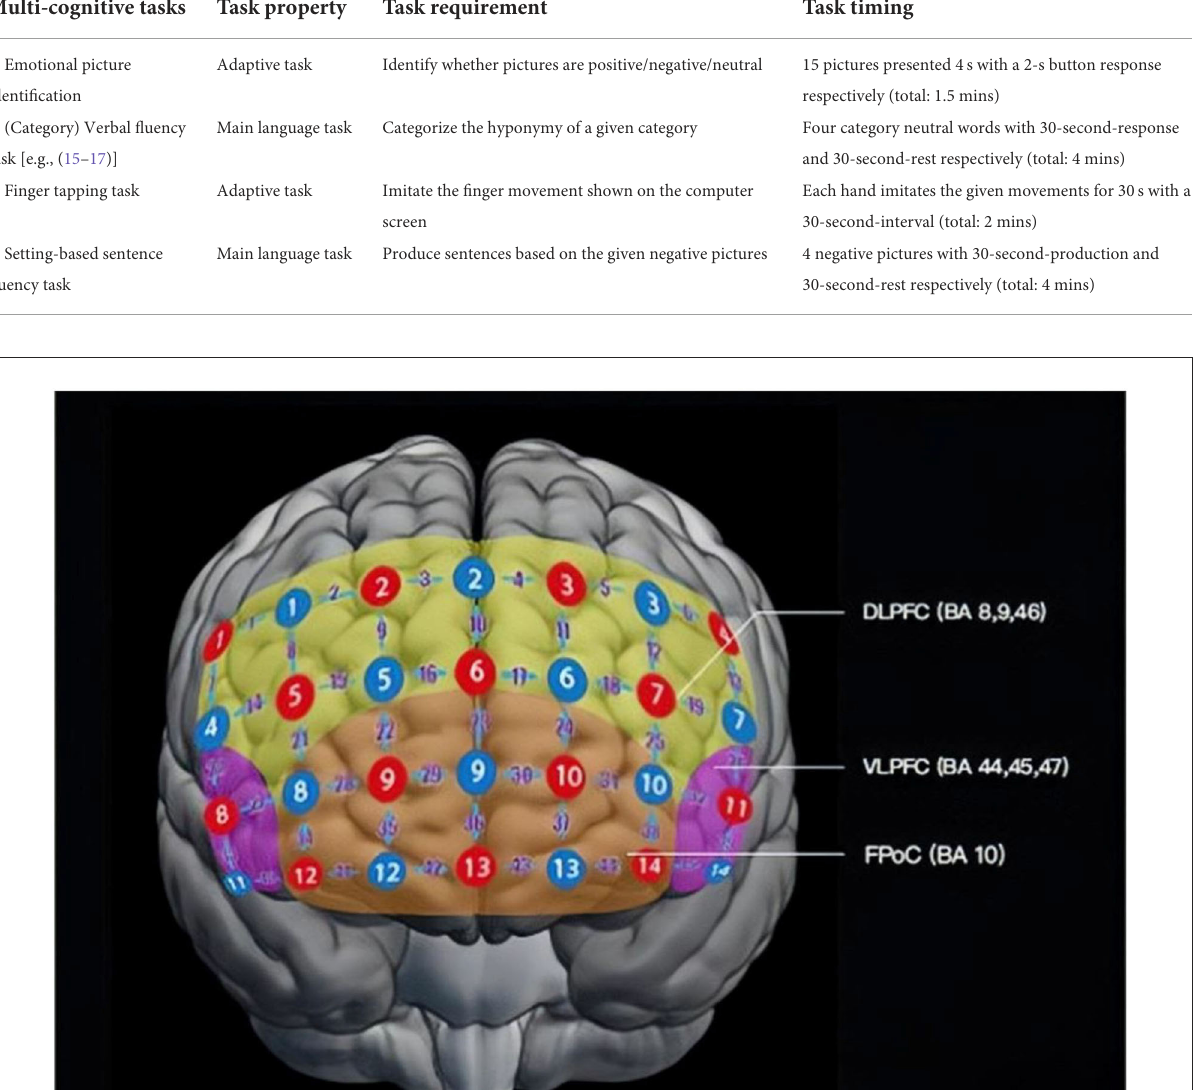
TABLE 1 Detailed introduction of the multi-cognitive